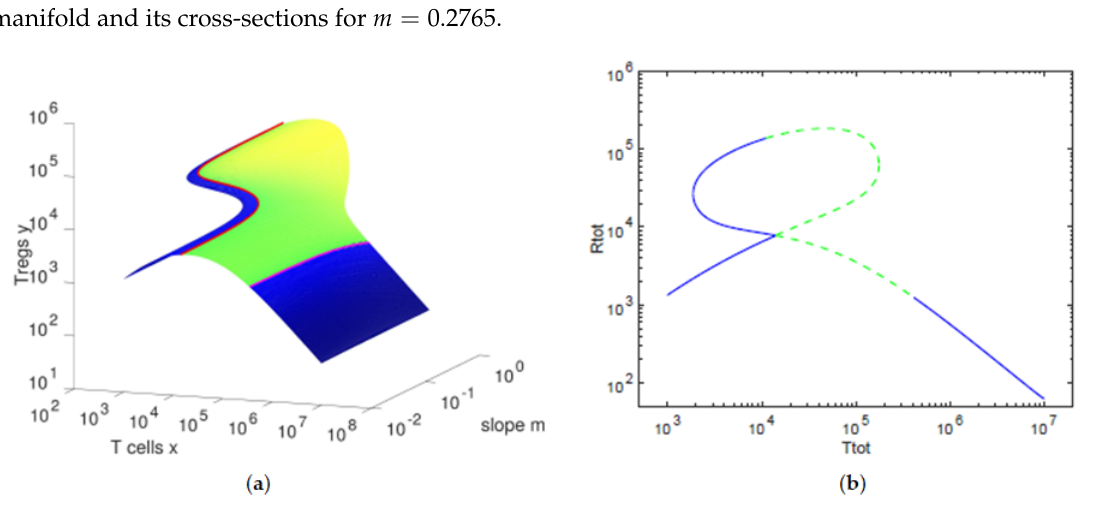
Figure 1. Equilibria manifold obtained from Theorem 1. ( a ) balance between the concentration of T cells x = T + T ∗ and that of Tregs y = R + R ∗ . The shading color indicates the real part of the largest eigenvalue Re ( λ ) , increasing from black to blue for stable equilibria, and unstable equilibria from green to yellow. The red and the magenta lines show the bifurcations, when Re ( λ ) = 0. ( b ) cross-section for m = 0.2765. The line type indicates stable (solid) or unstable (dashes)